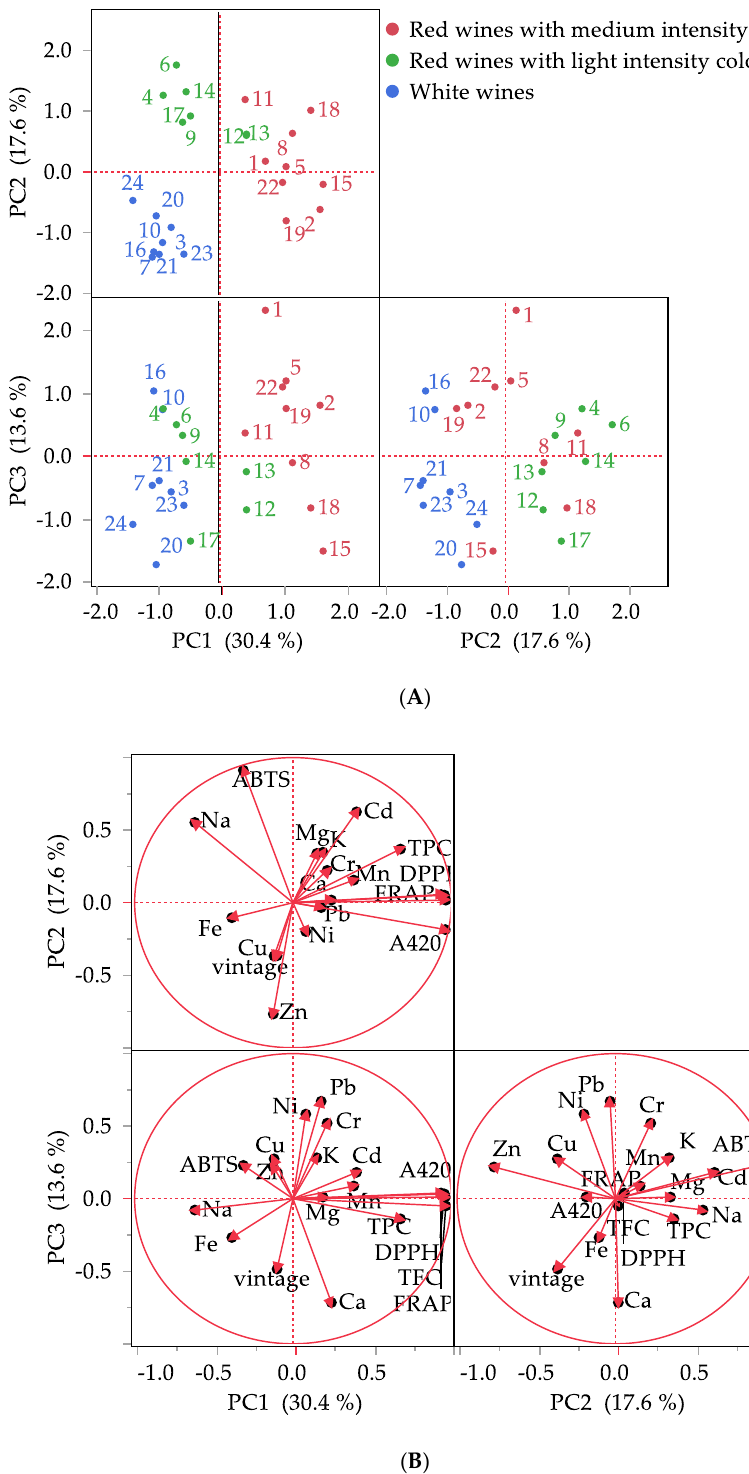
Figure 2. Principal component analysis (PCA). Biplot representation of samples ( A ) and variables ( B ) for wines. Different colors in the Biplot of samples represent the clusters as reported in the Figure 1. The variables were separated in two groups (cluster 1 and cluster 2); cluster 1 comprises the elements Cu, Fe, Zn, Na, Ca and vintage, whereas the other is made of two subgroups, one of which (subcluster 1) contains TFC, DPPH, FRAP and absorption at 420 nm whereas the other (subcluster 2) comprises the rest of variables. Looking at cluster 1 where the Cu, Fe, Zn, Na and Ca elements are